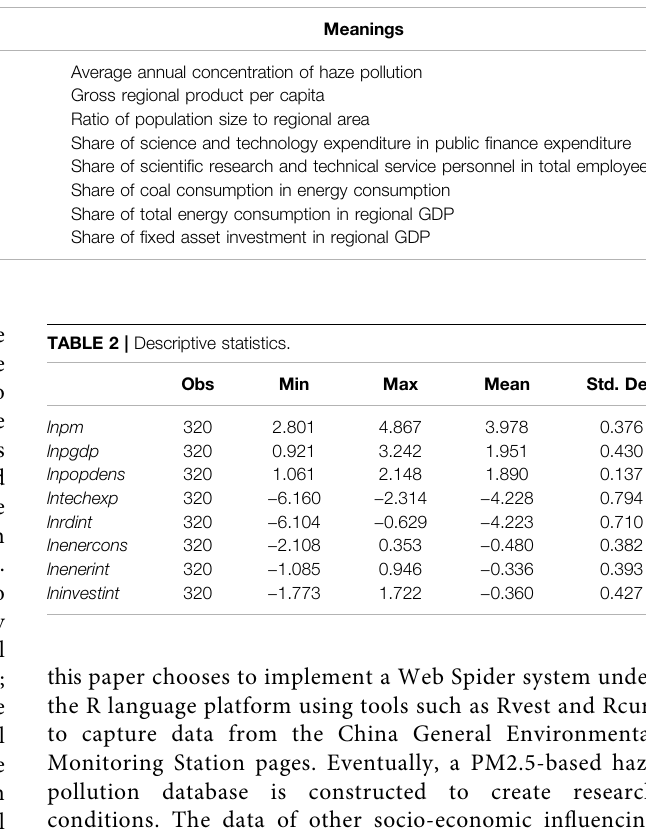
TABLE 1 | Variable de fi